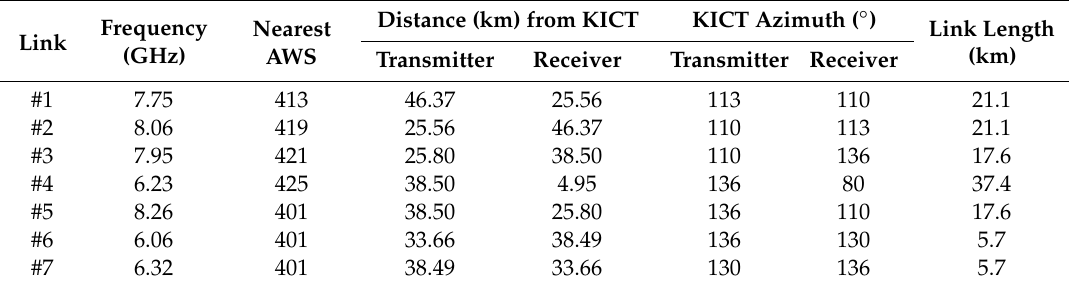
Table 2. Characteristics of microwave